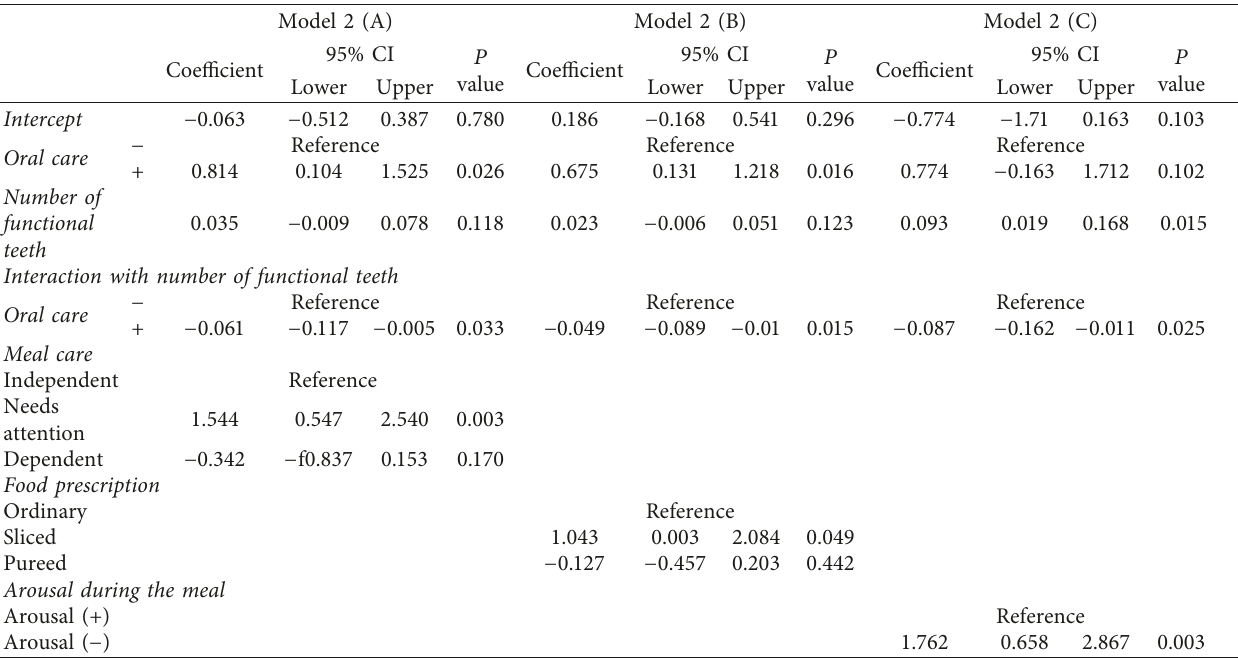
Table 2: Effect of dietary or meal factors on fever, adjusted by oral care and number of functional teeth.